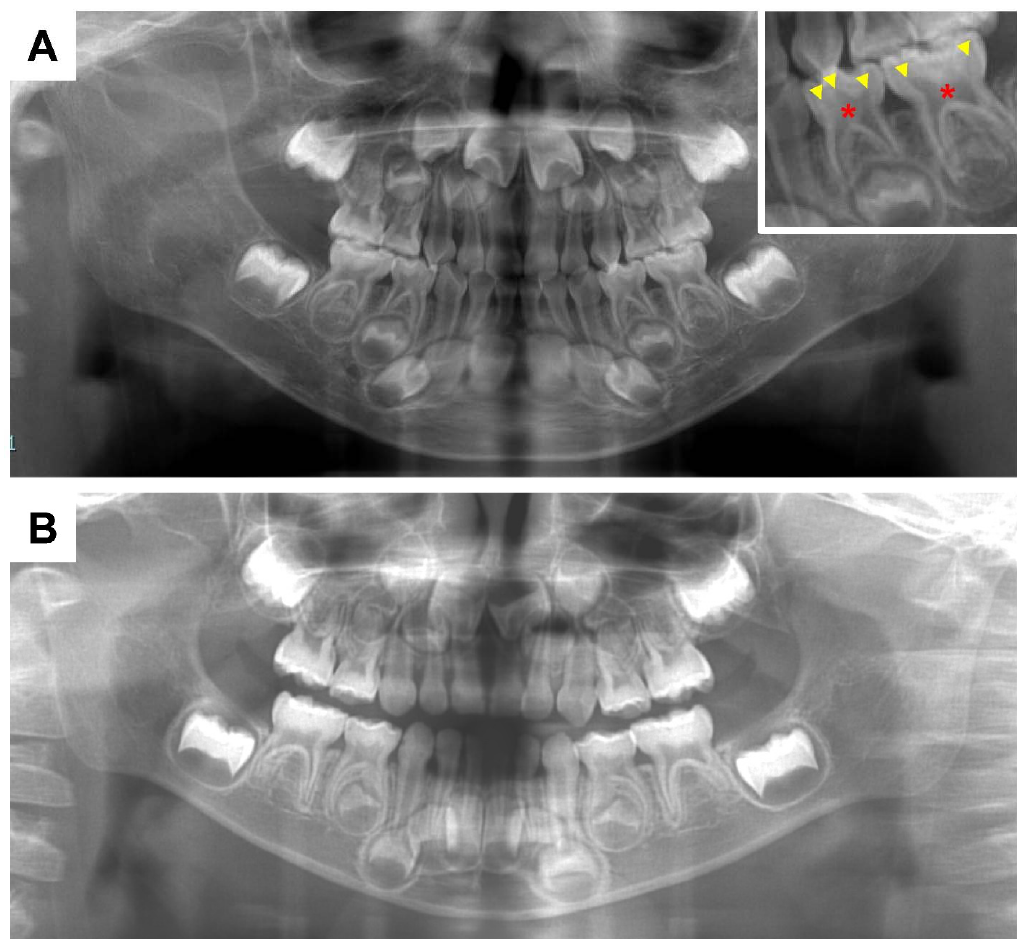
Figure 3. Panoramic radiographs. ( A ) Female X ‐ linked hypophosphatemia (XLH) patient aged 3 years 11 months. The square on the upper right is an enlargement of the primary mandibular left molar region. Wide pulp chambers (asterisks) and prominent pulp horns (arrowheads) can be seen. ( B ) Healthy age ‐ matched female.